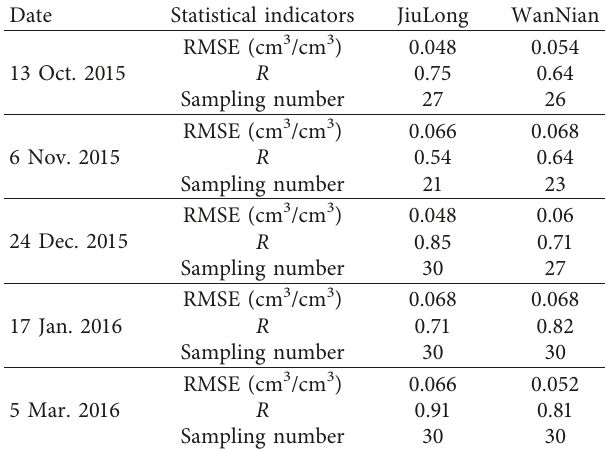
Figure 8: Comparison between the measured and estimated soil moisture using the developed Alpha model. (a) Comparison between the estimated and measured soil moisture on 13 Oct. 2015. (b) Comparison between the estimated and measured soil moisture on 6 Nov. 2015. (c) Comparison between the estimated and measured soil moisture on 24 Dec. 2015. (d) Comparison between the estimated and measured soil moisture on 17 Jan. 2016. (e) Comparison between the estimated and measured soil moisture on 5 Mar. 2016. Table 5: Quantitative evaluation of estimated soil moisture using the developed Alpha